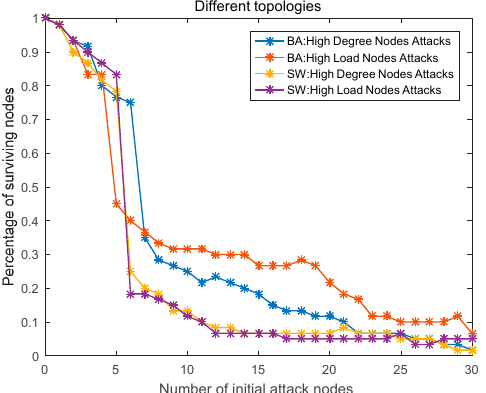
Figure 13. Effect of different topologies on system survivability.